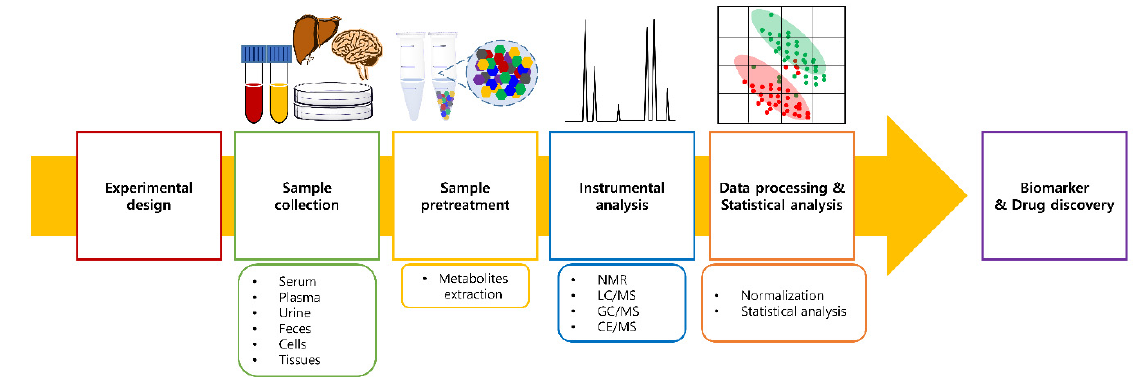
Figure 1. General metabolomics workflow in biomarker and drug discovery.